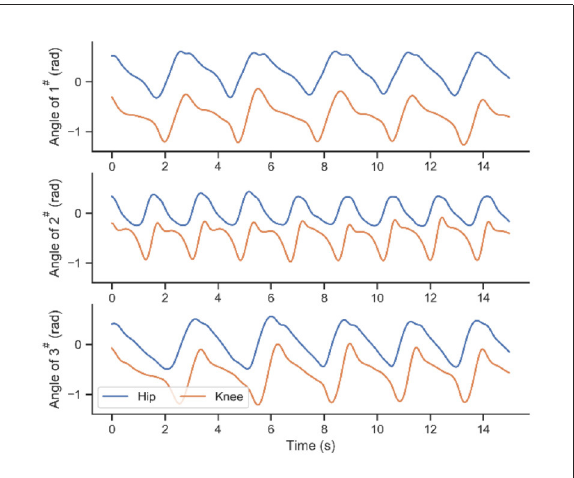
FIGURE4 The walking trajectory data of subjects 1 # , 2 # , 3 #